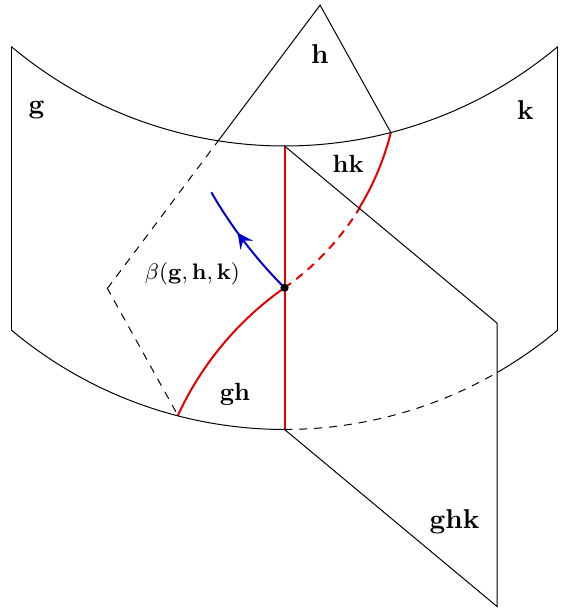
Figure 1 . A junction where zero-form symmetry defects of type g , h , k , ghk ∈ G meet in codimension three. This configuration is generic in spacetime dimension three and above. The junctions of three codimension-one defects are in red, and their intersection is the black point. At the codimension-three intersection, a one-form symmetry defect β ( g , h , k ) emanates, signaling the 2-group symmetry. In d dimensions, all objects span the remaining d − 3